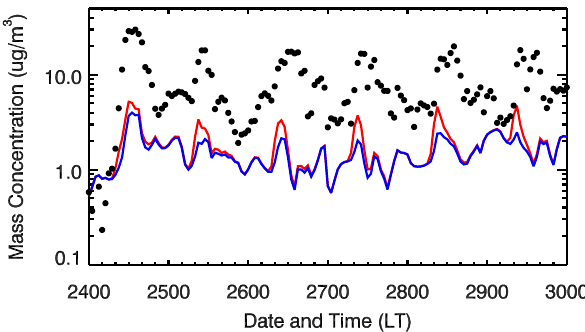
Fig. 10. Simulated submicron SOA and observed submicron OOA at T0 during the 24–29 March 2006. The black dots denote the observation and the red and blue lines represent the simulations in the E-case and H-case,